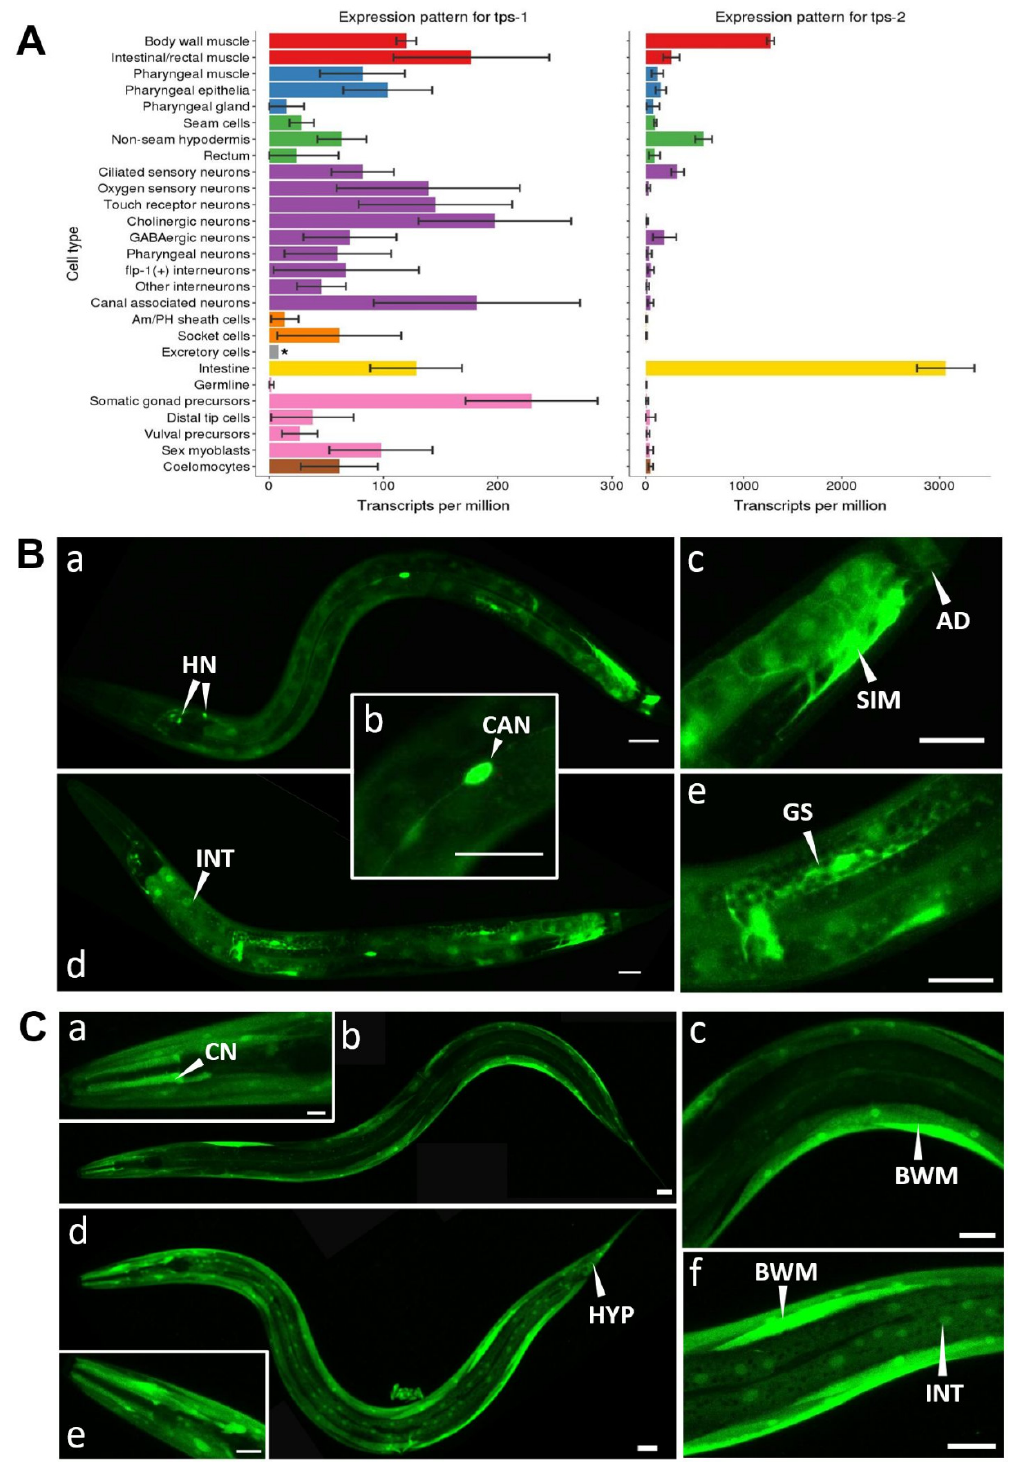
Figure 1. Expression patterns for tps-1 and tps-2 : ( A ) tps expression based on transcriptional profiling data from [35]. Note that scales of tps-1 and tps-2 bar graphs differ tenfold. ( B ) Transcriptional tps-1p::gfp reporter strain fed with E. coli HT115 expressing empty vector ( a – c ) and daf-2 RNAi ( d , e ). ( C ) Transcriptional tps-2p::gfp reporter strain fed with E. coli HT115 expressing empty vector ( a – c ) and daf-2 RNAi ( d – f ). HN, head neuron; CAN, Canal-associated neuron; SIM, stomatointestinal muscle; AD, anal depressor muscle; INT, intestine; GS, gonadal sheath; CN, ciliated neuron; BWM, body wall muscle; HYP, hypodermis. Scale bars are 25 µm.